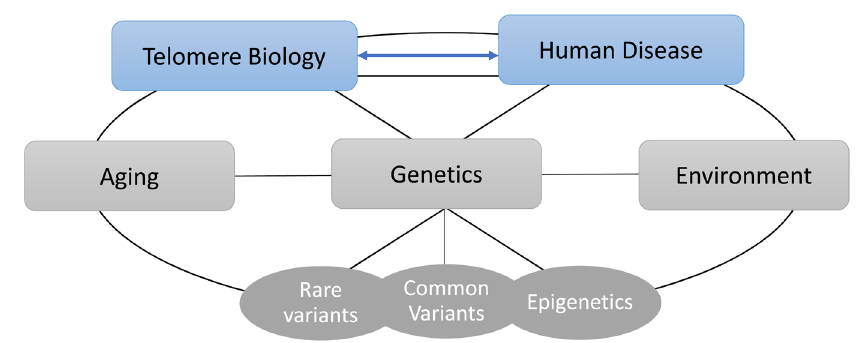
Figure 1. Factors associated with human disease are integrally connected to telomere biology. This schematic illustrates the complex relationships between telomere biology, disease, aging, genetics, and environmental exposures, all of which should be considered in studies of telomeres and human disease.